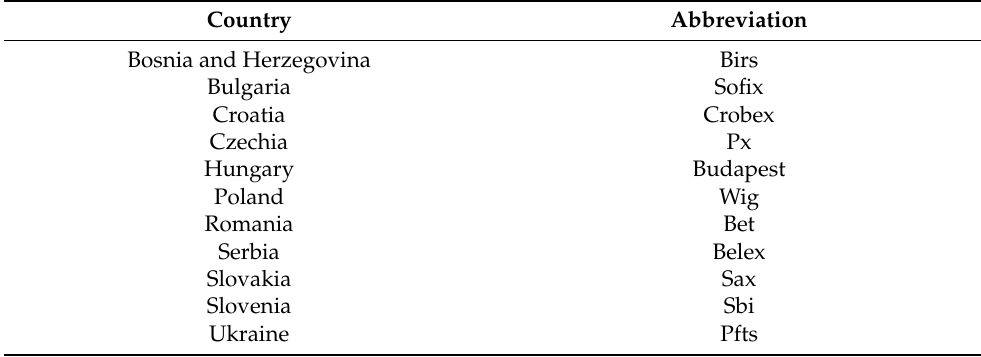
Table 1. Description of the data and sources.